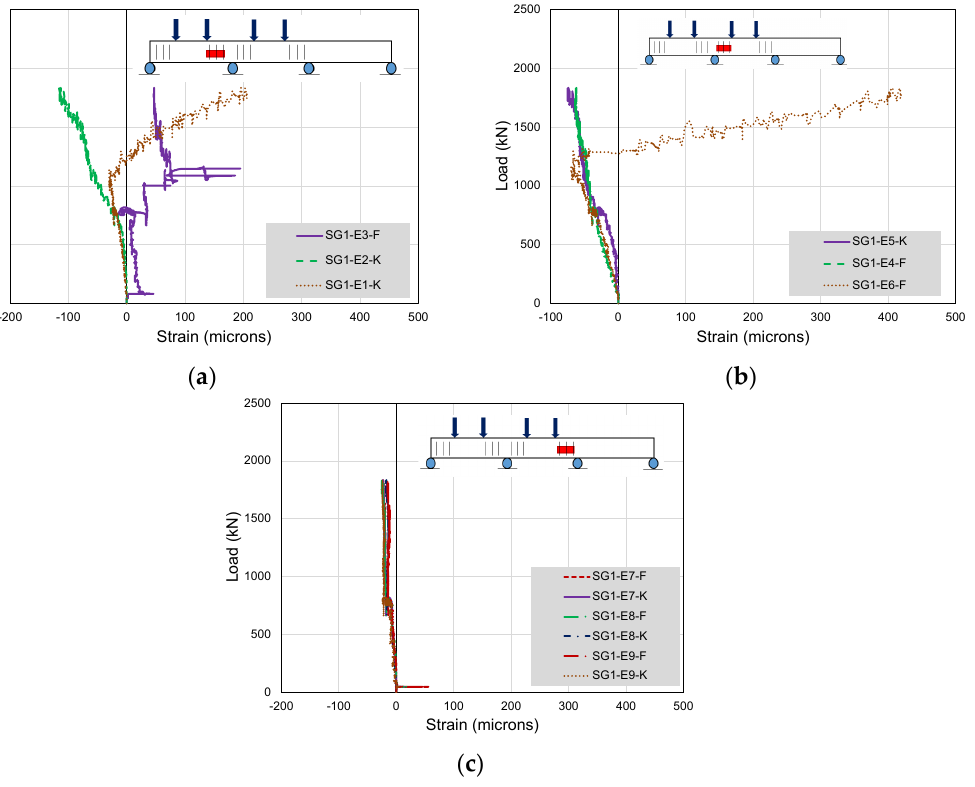
Figure 27. Load versus strain responses in load setup SP-1-L04 ( a ) DE1-E3, ( b ) E4-E6, ( c ) E7–E9.